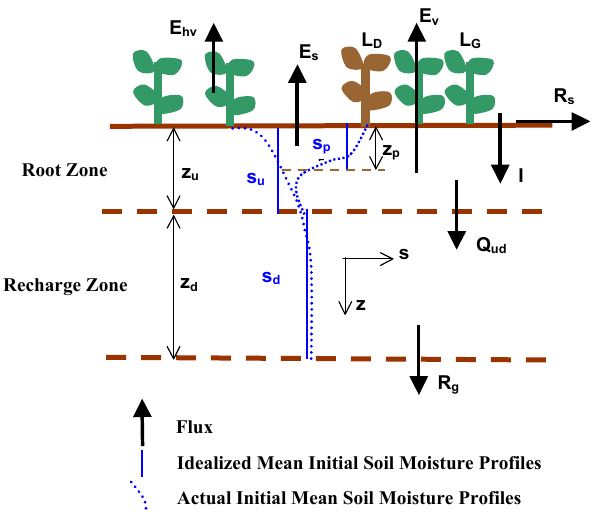
Fig. 2. Schematic of the